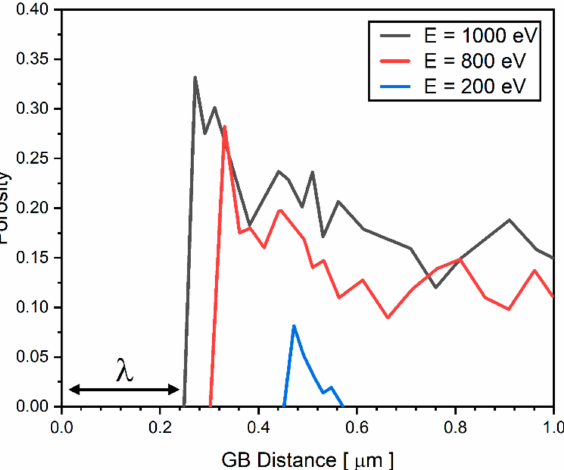
Figure 7. The porosity as a function of distance from GB for three different irradiation energies: E = 200 eV, E = 800 eV, and E = 1000 eV. The width of void denuded zone is marked as λ in the figure. In order to investigate the formation of VDZ under irradiation, the width of VDZs (W vdz ) is plotted in Figure 8 as a function of irradiation energy and temperature. As shown, the W vdz decreases with an increase in irradiation energy and temperature. It is also shown in Figure 8 that W vdz changes more sensitively in response to the change in irradiation energy than the temperature change. The difference in the vacancy concentration between grain interiors and the vicinity of GBs leads to the diffusion of vacancies, and thus the formation of VDZs is controlled by such diffusion [52].